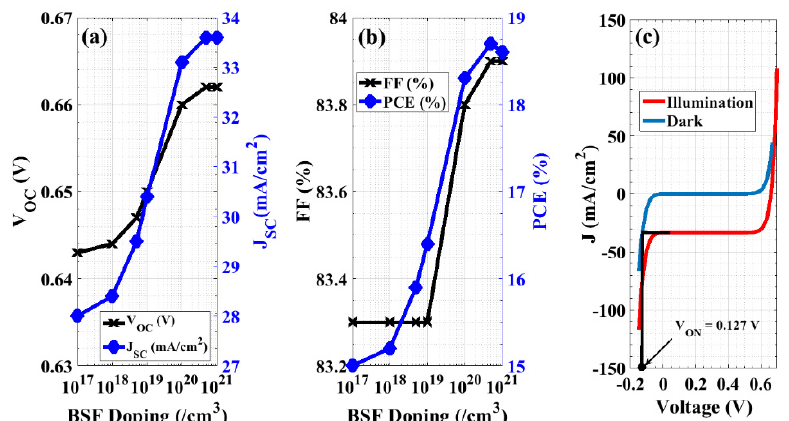
Figure 10. Performance of the modified cell by optimizing the doping density of the BSF layer. ( a ) Open-circuit voltage and short-circuit current density, ( b ) the fill factor and power conversion efficiency, and ( c ) J-V characteristics under illumination (red) and in the dark situation (blue) to determine the ON-state voltage of the backward diode.